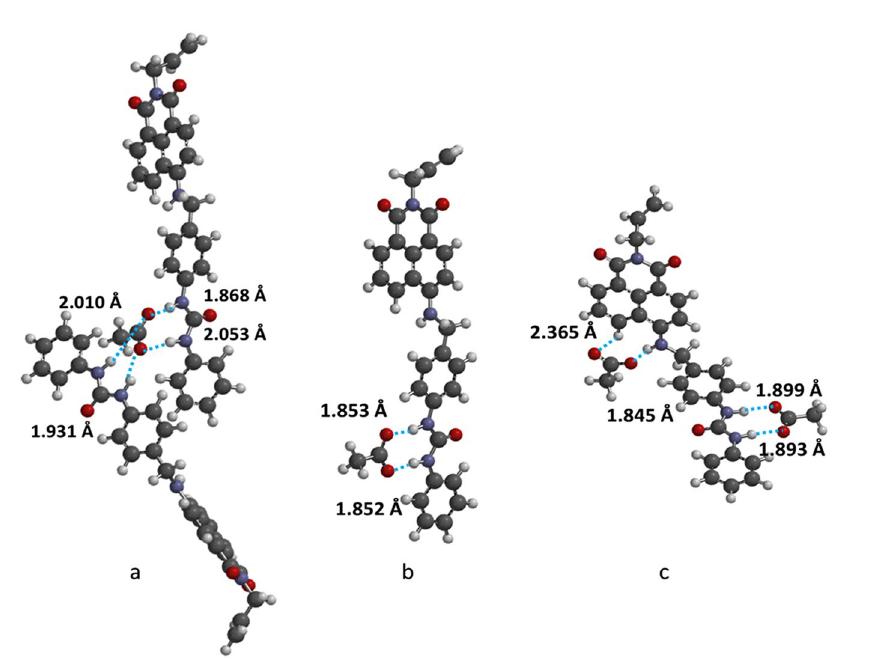
Figure 5. ( a ) 2:1, ( b ) 1:1 and ( c ) 1:2 Proposed structure of adducts formed between 4 and acetate showing H– bonded pairs and bond lengths (Hartree Fock 6–31G *